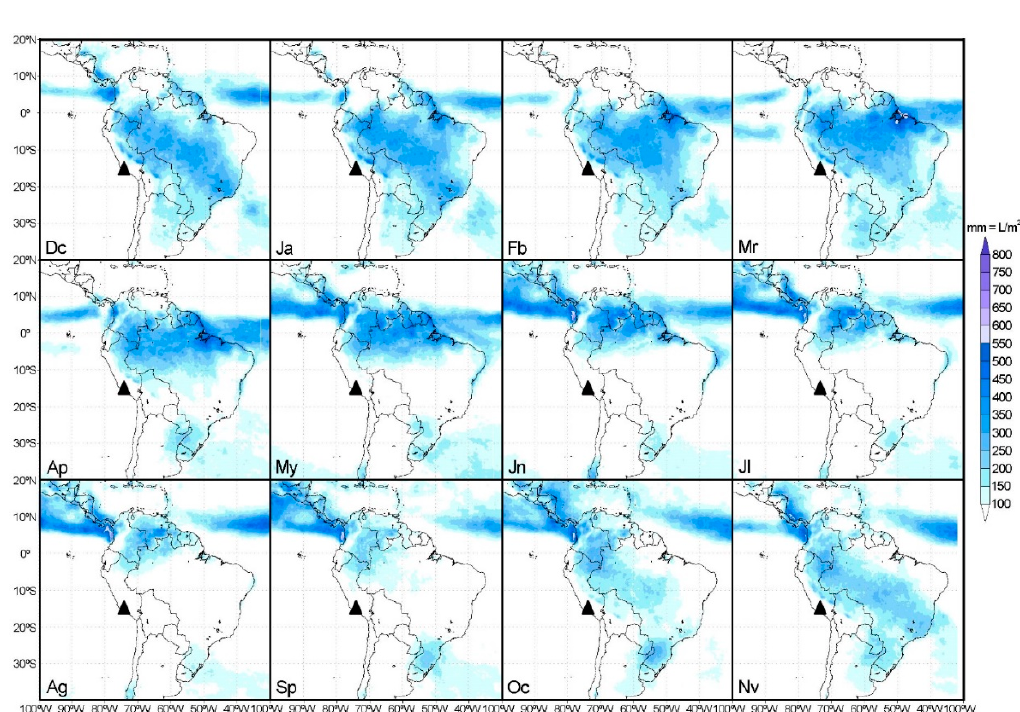
Figure 2. Monthly precipitation averages 1998–2007. Tropical Rainfall Measuring Mission (TRMM-NASA). The black triangles indicate the Coropuna location.